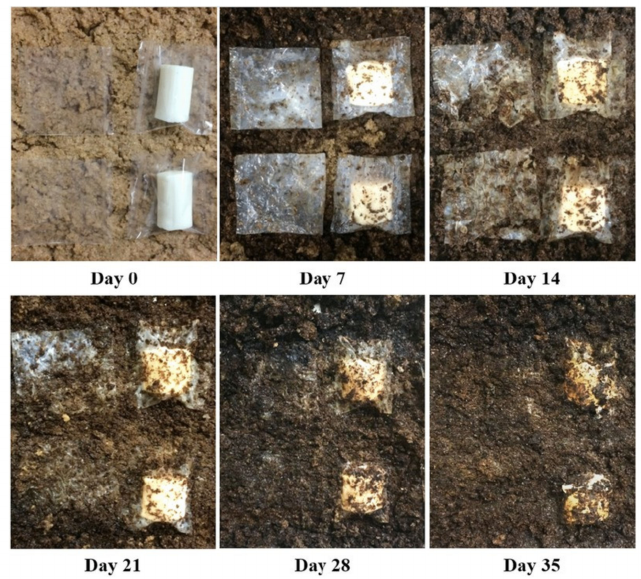
Figure 6. Effect of CP treatment on biodegradability of PLA film when composted at 90% relative humidity at 37 ◦ C for 35 days. Reprinted with permission from ref. [67]. Copyright John Wiley and Sons